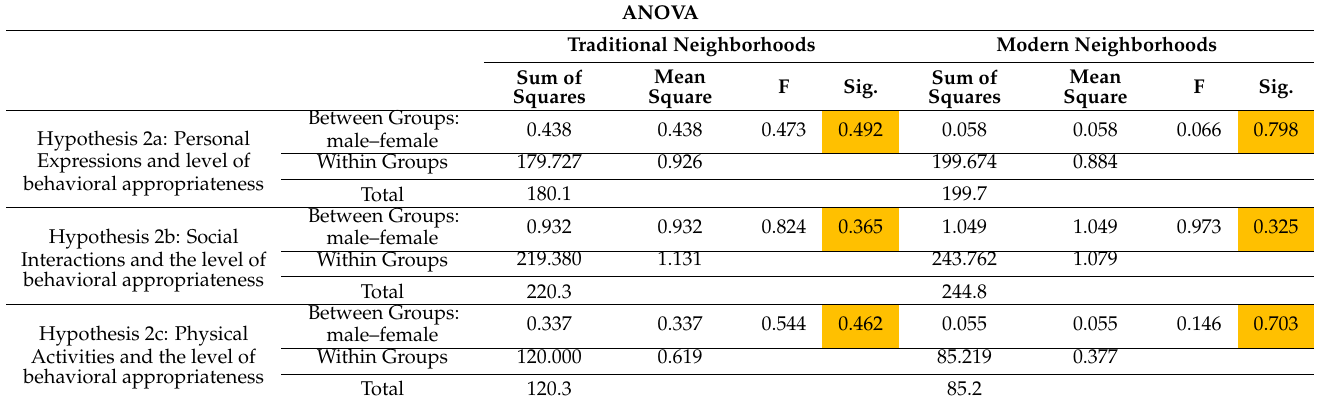
Table 3. ANOVA analysis exploring significant gendered intention differences in two districts, hypothesis 2a–c. ANOVA Traditional Neighborhoods Modern Neighborhoods Mean Sum of Square Sig. Squares